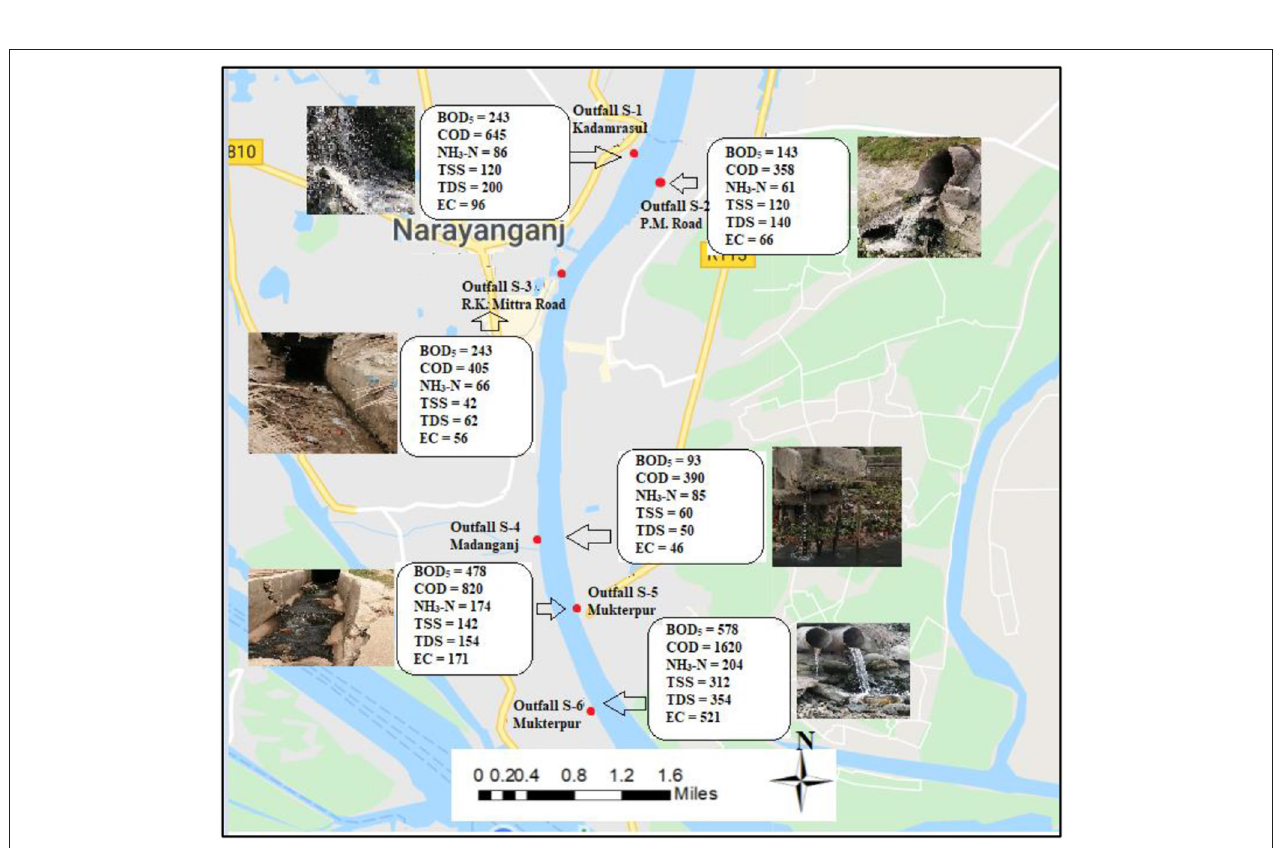
FIGURE 10 | Waste load contribution in Shitalakshya